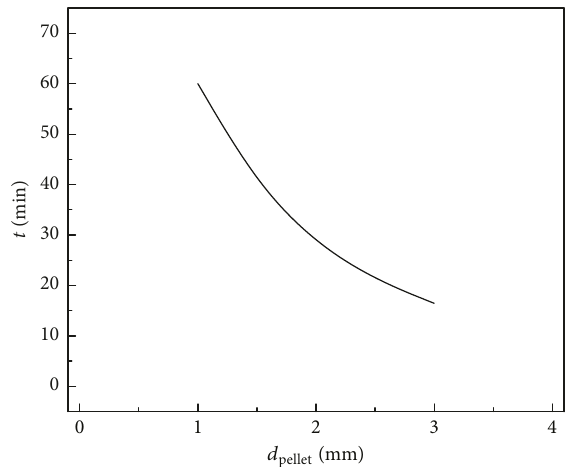
Figure 12: Adsorption unit cycle time as a function of the pellet diameter, for a required residual concentration at the outlet of the adsorption column ( 𝑦 break ) of 1.40mmol L −1 and impurity in the oil phase ( 𝑥 Feed ) equal to 140mmol L −1